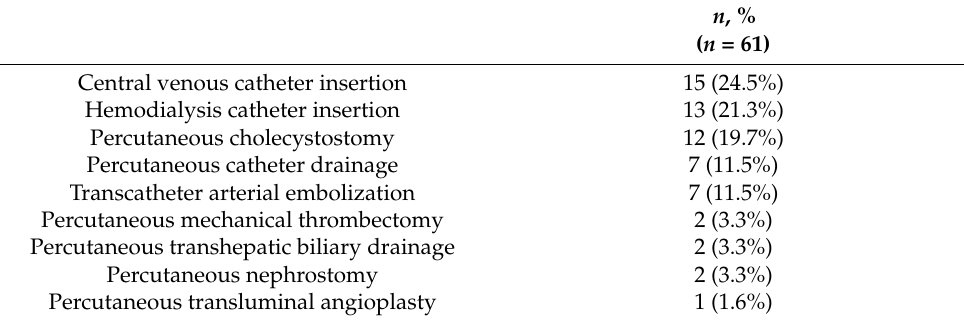
Table 2. Types of interventional radiology